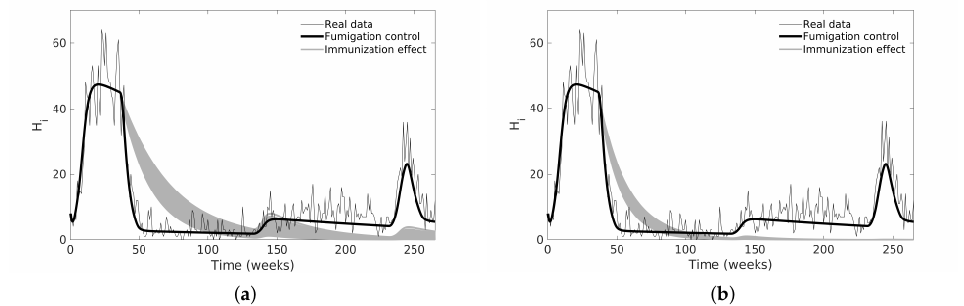
Figure 8. Dengue model simulations using estimated nominal values and immunization control by vaccination. We removed chemical control pulses for immunization simulations and left those that represented the mosquito population increase. ( a ) immunization of the 10 to 20% of total human population; ( b ) immunization of the 20 to 30% of total human